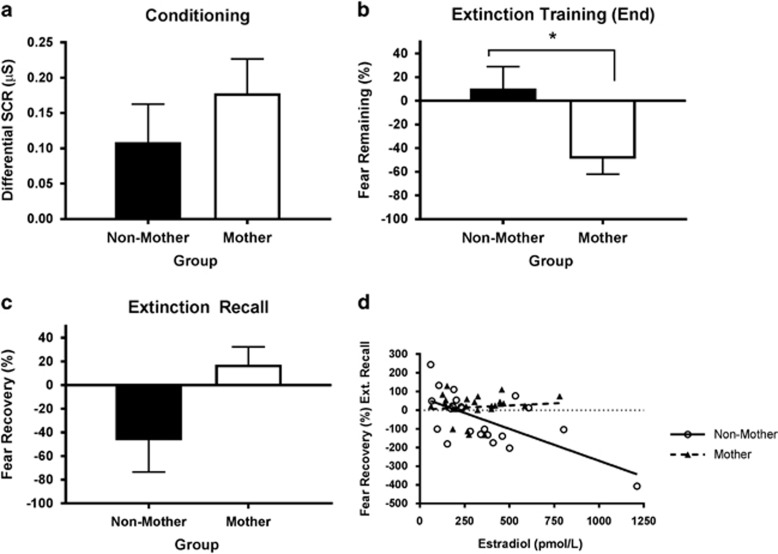
(a) Mean (±s.e.m.) differential skin conductance response (SCR; μS) for non-mother (n=23) and mother (n=23) groups during conditioning in experiment 4. (b) Mean (±s.e.m.) fear remaining (%) at the end of extinction training in experiment 4. *Non-mothers > mothers (P<0.05). (c) Mean (±s.e.m.) fear recovery (%) during extinction recall in experiment 4. (d) Mean fear recovery (%) as a function of estradiol (pm/l) during extinction recall in experiment 4.